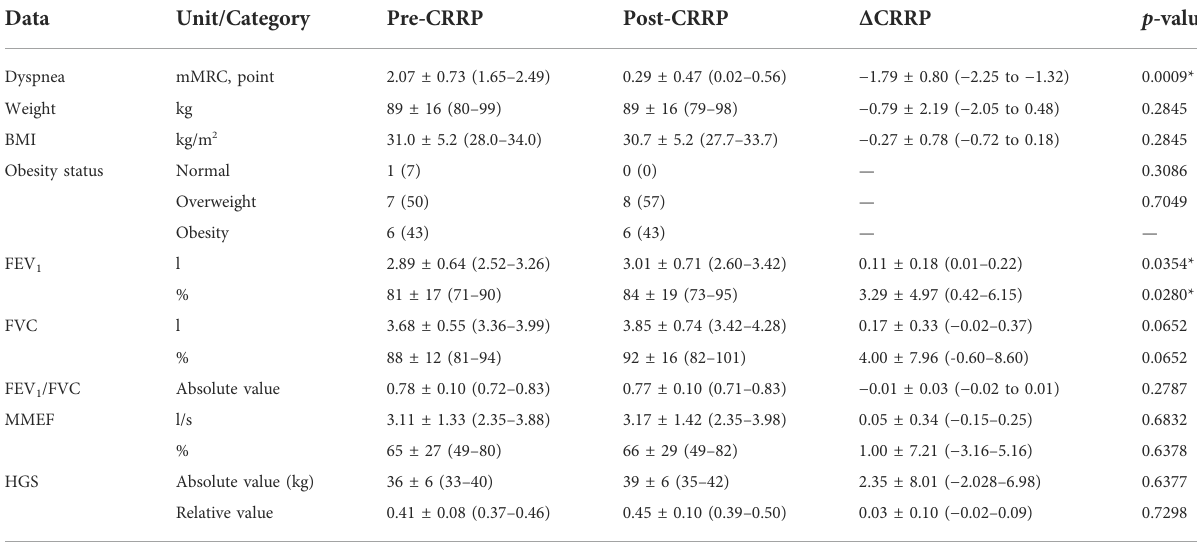
TABLE 2 Impact of CRRP on dyspnea, and anthropometric, spirometric and HGS data of patients with coronavirus disease 2019 ( n =